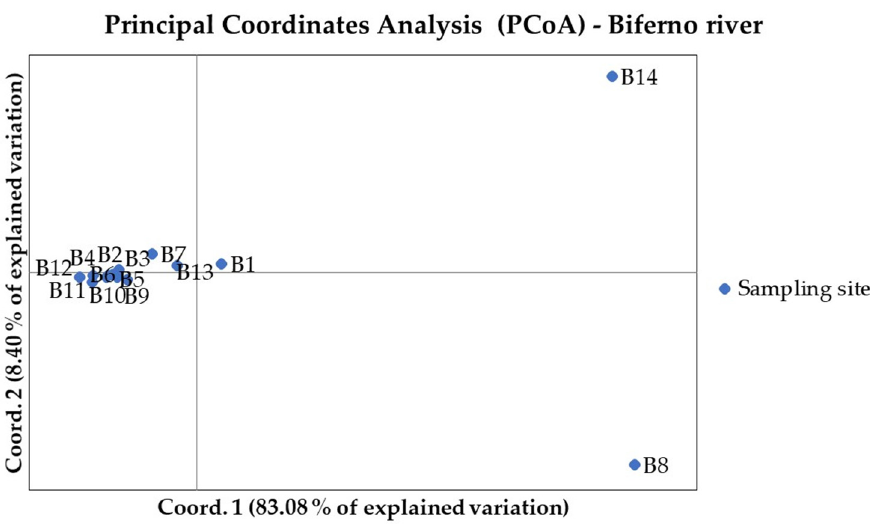
Figure 3. Principal coordinates analysis (PCoA) performed considering sampling sites in Biferno river. Sample locations and codes are detailed in Table S1.